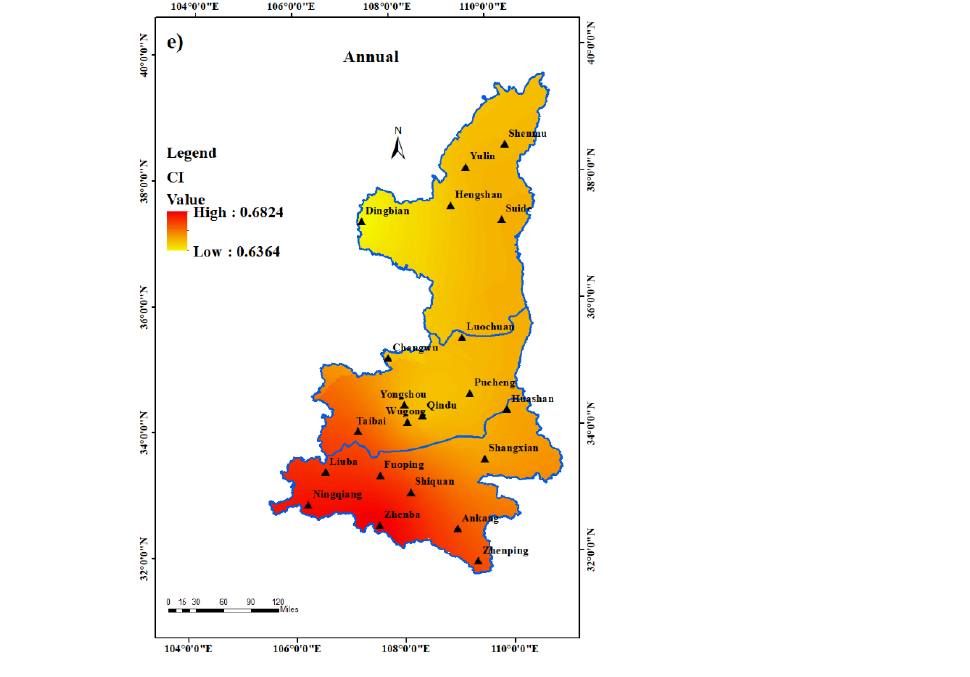
Note: * represent a significant correlation at the 0.05 level.